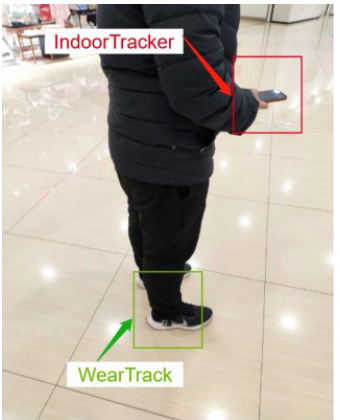
Figure 8 . Display of Each Reference